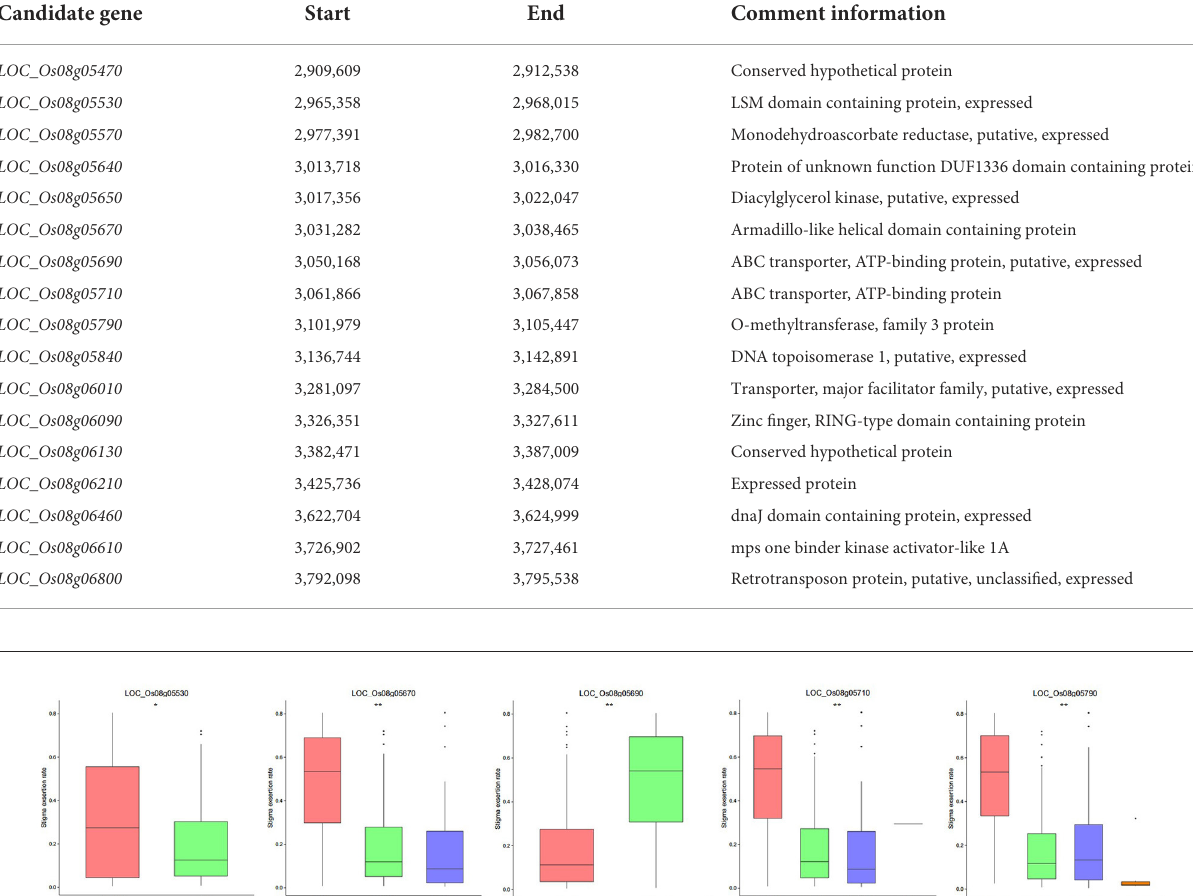
TABLE 5 Annotation information of candidate genes identified via linkage analysis and GWAS.